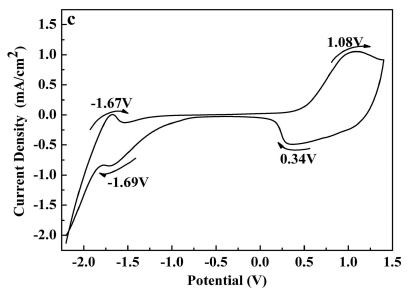
Figure 2. Cyclic voltammograms of the polymer films of P1 ( a ); P2 ( b ) and P3 ( c ).